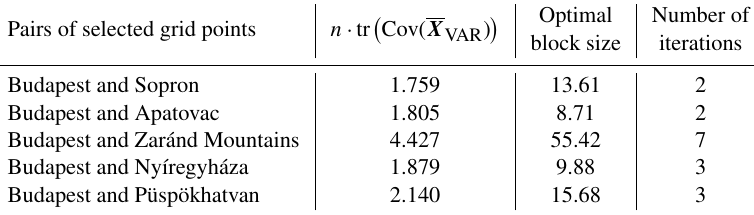
Table 7. p Values of the copula homogeneity test, if the first/second half of the sample is bootstrapped – based on 10 4 simulations. p values, bootstrapped half: Pairs of selected grid points first second